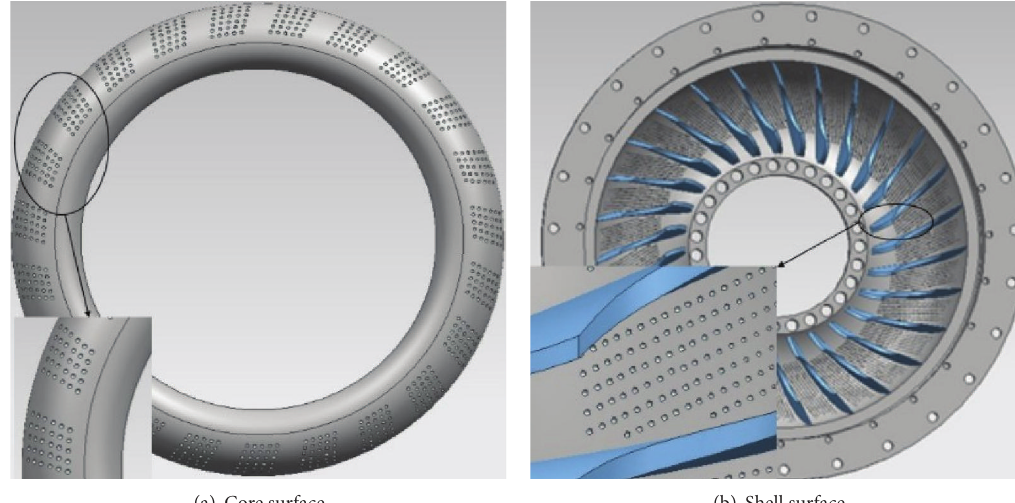
Figure 12: Nonsmooth pump